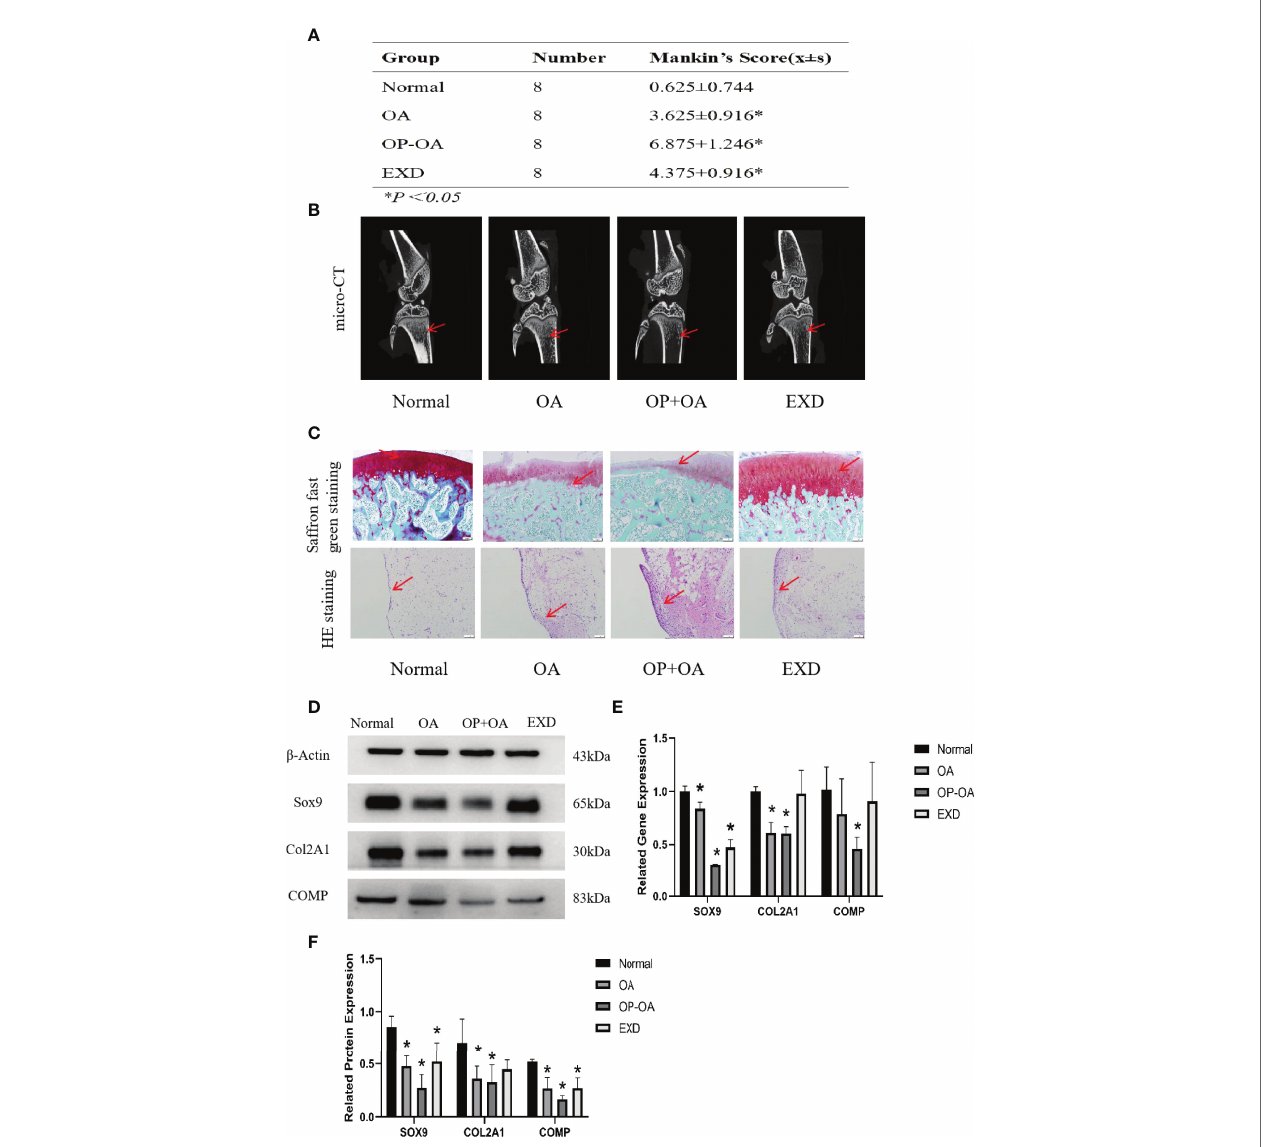
FIGURE 1 | EXD can relieve cartilage destruction of Osteoporotic OA and promote cartilage repair. (A) The Mankin ’ s score of the normal group and EXD group were signi fi cantly lower than those of the OA group and OP-OA group. The score of OP-OA group was higher than that of OA group, and the in fl ammatory in fi ltration and cartilage damage were obvious. (B) Micro-CT veri fi cation of osteoporotic trabecular bone in each group of rats. Compared with normal and OA, the trabecular bone in the proximal tibia of OP-OA was sparse and showed low signal density, while the trabecular bone in the proximal tibia after EXD intervention was dense and showed high signal density. The red-pointing area indicates the increase or decrease of trabecular bone. (C) Cartilage histomorphology of each group stained with safranin O-fast green and H&E,100x scale bar=100 m m. Red-pointing areas indicate cartilage changes and cellular in fi ltration. (D, E) Western blot analysis of the effects of EXD on SOX9, COL2A1, and COMP in rat cartilage tissue. (F) Relative protein and gene expression of SOX9, COL2A1, and COMP in each group of cartilage tissue. *P<0.05